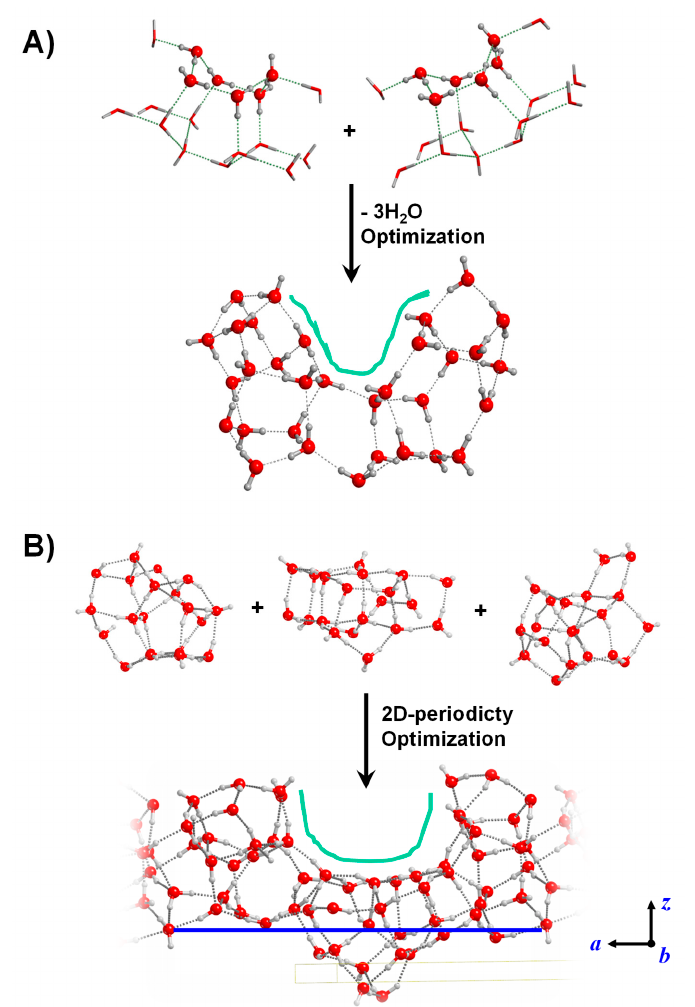
Figure 7. Water ice surface models exhibiting a cavity as surface defect. ( A ) Cluster surface model generated by joining two smaller water clusters and removing 3 H 2 O molecules. ( B ) Periodic slab surface model generated by joining three smaller water clusters, in which the 2D periodicity has been imposed to convert the original finite system into a periodic one. The work highlights the strategies and problems to be overcome to construct repre- sentative structurally atomistic surface models for IS grains suitable for computational